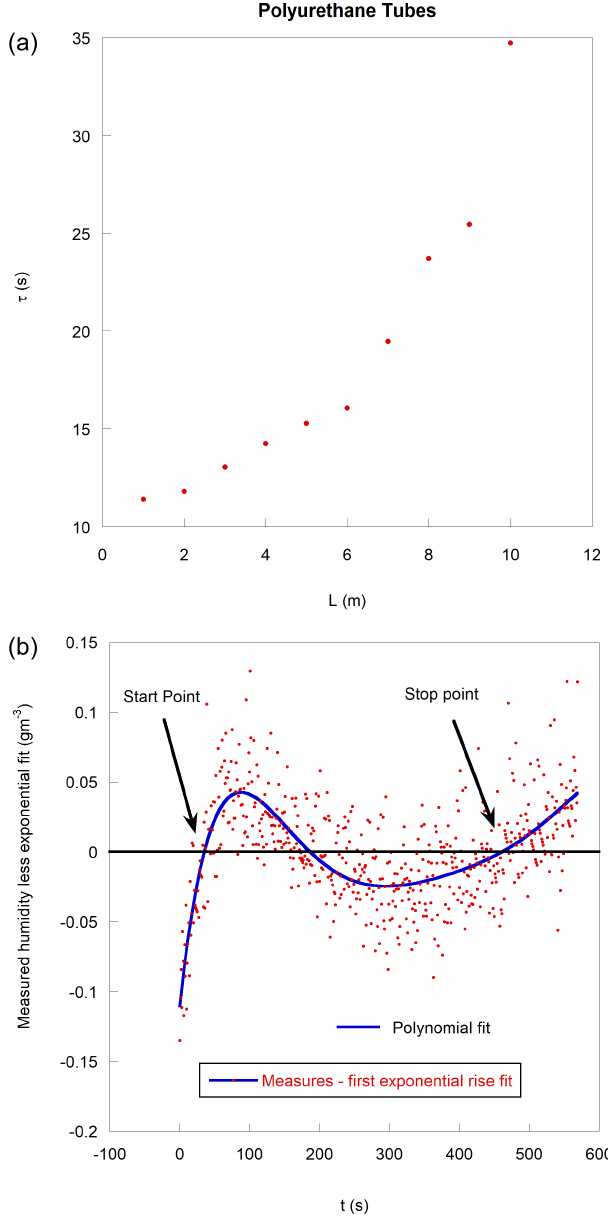
Figure 2. (a) Apparent response time of the polyurethane tubes ver- sus the length of the tubes. (b) Measured absolute humidity less ex- ponential fit (residuals), giving start and stop points for a second